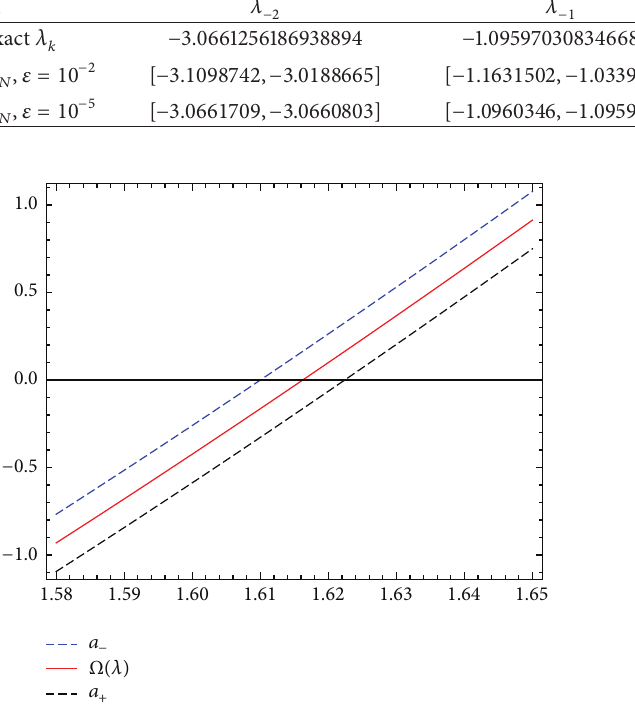
Figure 3: The enclosure interval dominating 𝜆 1 for ℎ = 0.1 , 𝑁 = 25 , and 𝜀 = 10 −2 .